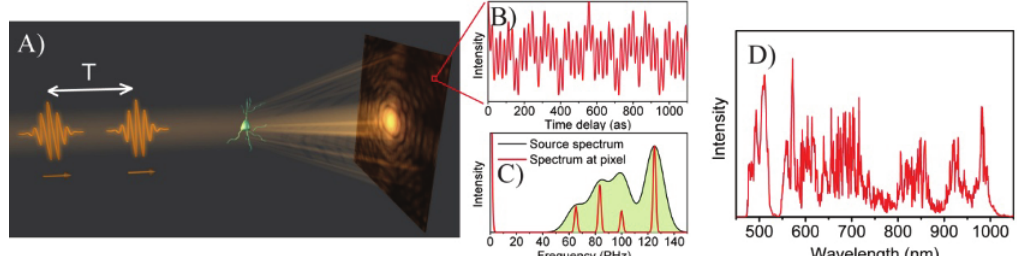
Fig. 1. A) Concept of two-pulse Fourier-transform lensless imaging. A lensless imaging experiment is performed with two coherent pulses, while scanning the time delay between them. B) Simulation of the signal on a single pixel as a function of the time delay. C) A Fourier transformation of the signal in B directly resolves the spectral components scattered onto that specific pixel. D) Spectrum of the octave-spanning white-light continuum used in our imaging